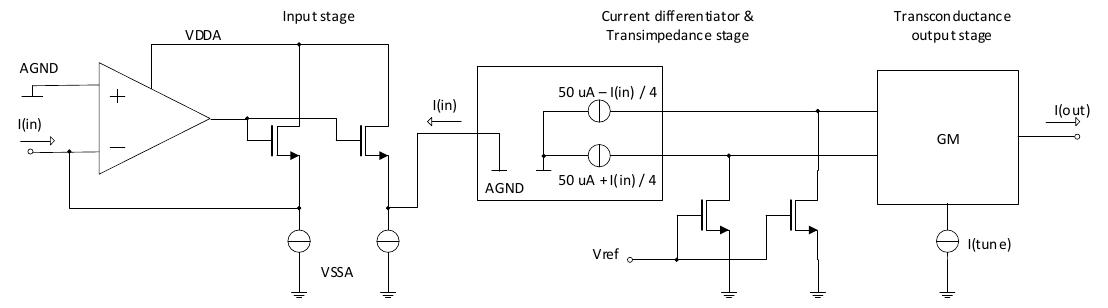
Figure 1. A principal topology of the current amplifier with tunable gain.